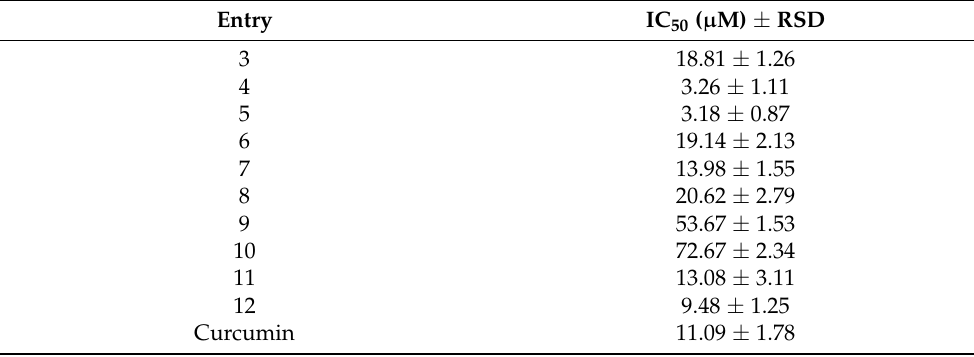
Table 1. Antiaggregation action of synthesized compounds on A β 42 shown as IC 50